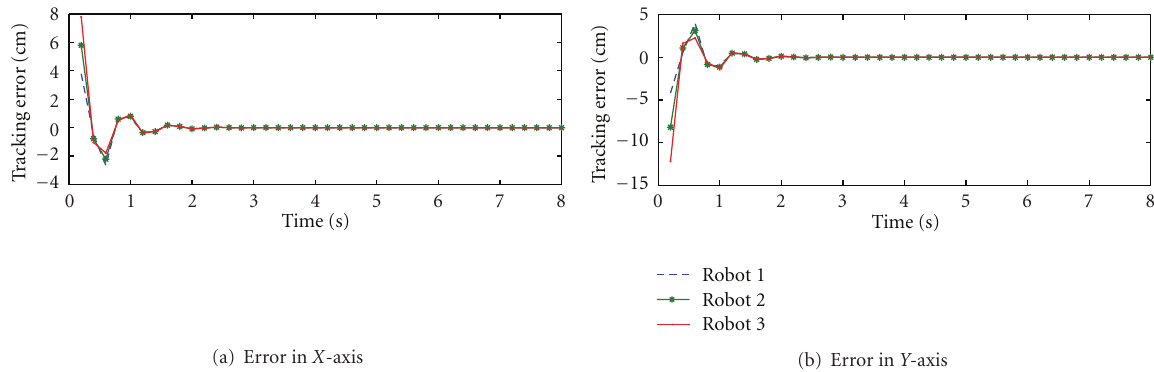
Figure 5: The tracking error of the robot group movement with time delay ( τ = 1 second): (a) X -axis; (b) Y -axis.